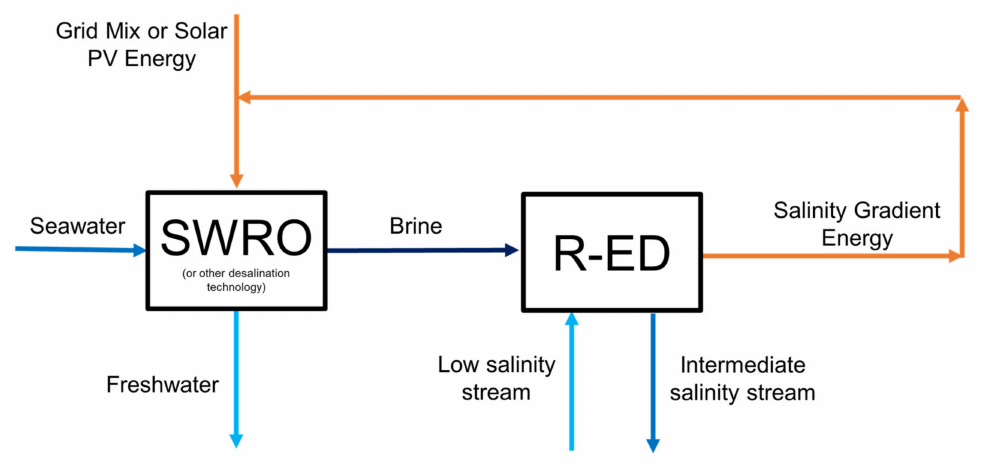
Figure 4. Alternative A2 flow